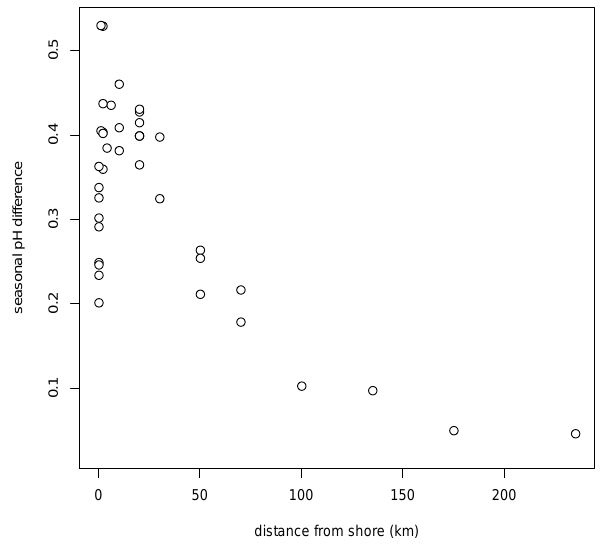
Fig. 8. Per station mean seasonal amplitudes for the different geo- graphical areas. Seasonal amplitudes were calculated by subtract- ing values measured in January from those measured in May, after